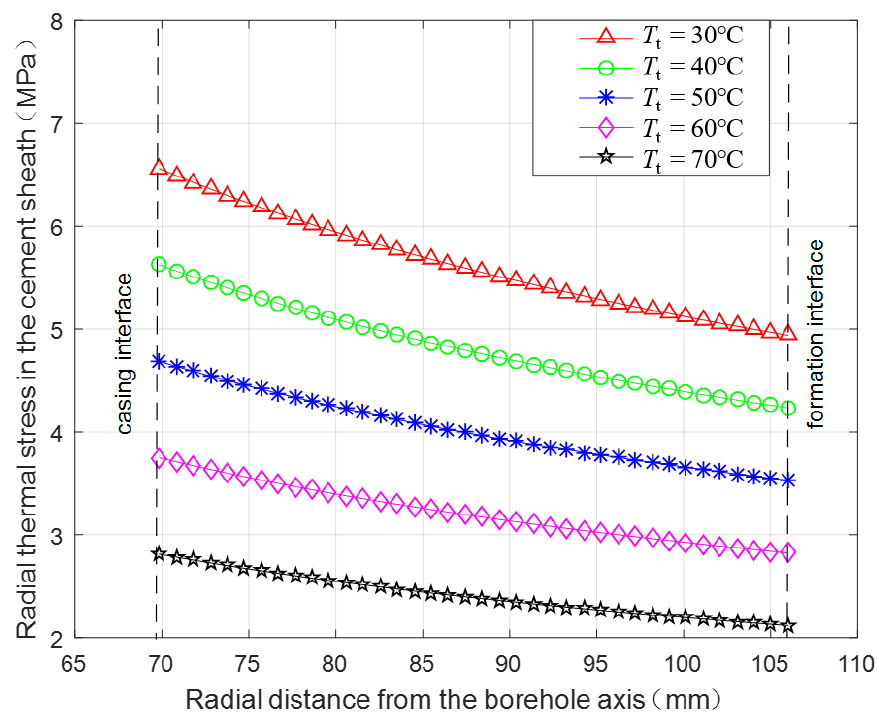
Figure 10. Radial distribution of the radial thermal stress in the cement sheath under different wellbore temperatures after fracturing fluid injection.